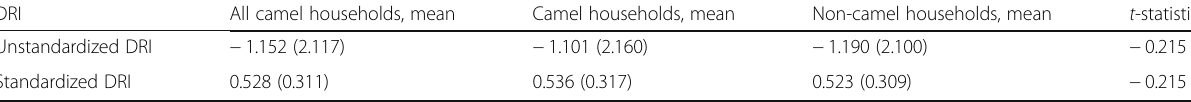
Table 5 Summary statistics for the unstandardized and standardized DRIs obtained from principal component analysis DRI All camel households, mean Camel households, mean